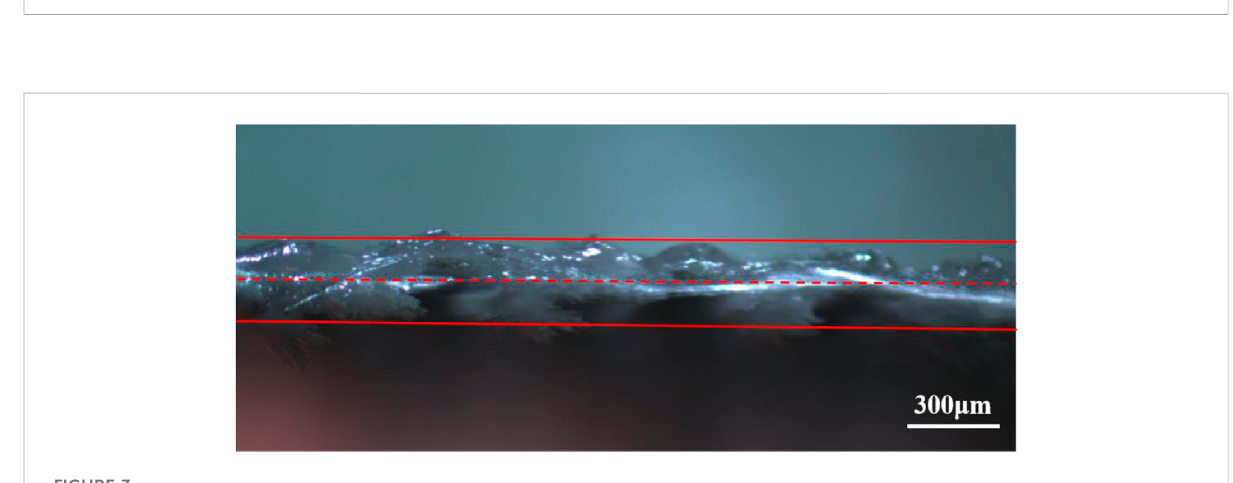
FIGURE 3 Optical micrograph of fi ber fabric impregnation